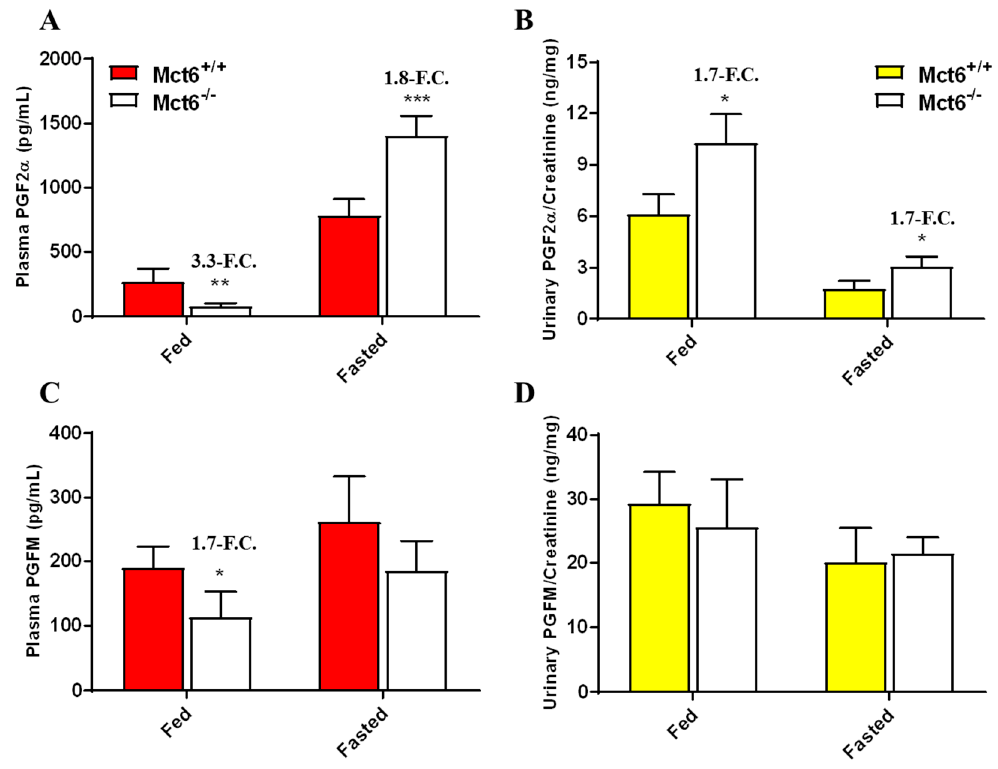
Figure 4. Plasma ( A / C ) and urinary ( B / D ) PGF2 α and PGFM concentrations in Mct6 +/+ and Mc6 -/- mice. Mice were 15–25 weeks of age (N = 3–5 per group). Urine values were normalized to creatinine concentration. Data are plotted as mean ± SD. (F.C.: fold change). Statistical comparisons are made between Mct6 +/+ versus Mct6 − / − mice ( * p < 0.05; ** p < 0.01; *** p < 0.001).